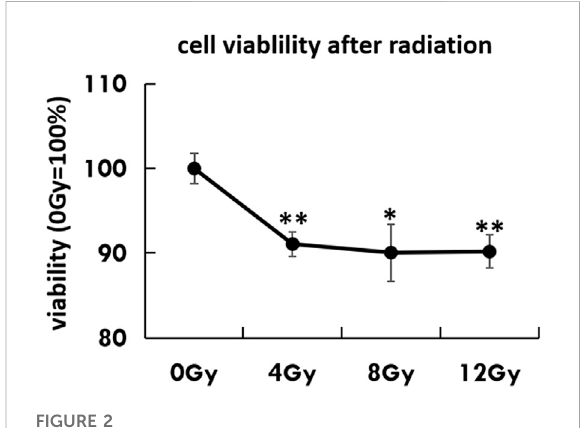
FIGURE 2 Cell viability was tested by CCK8 assay in untreated HT-1376 cells or different doses of irradiation.